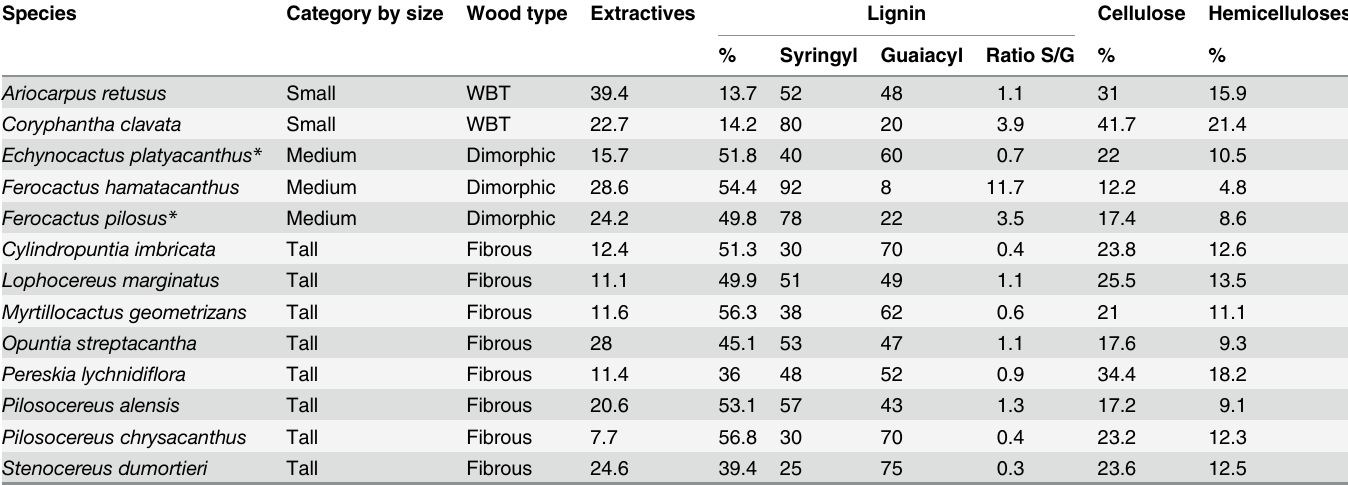
Table 2. Chemical composition of lower wood in mature individuals of thirteen species of Cactaceae.